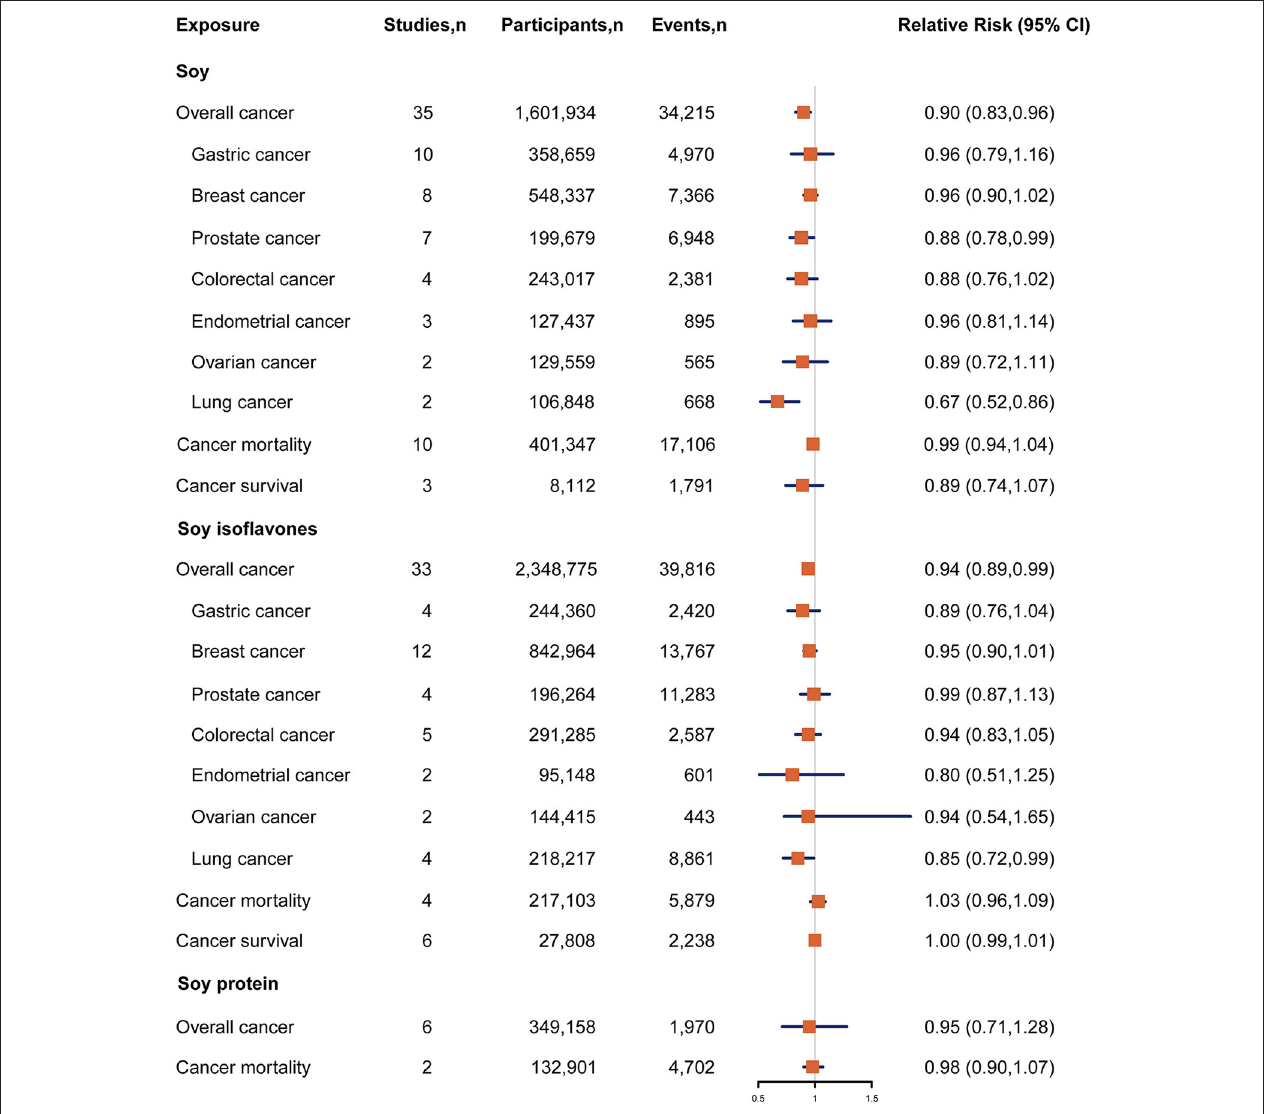
FIGURE 2 | Forest plot for association between soy, soy isoflavones and soy protein intake and risk of cancer incidence and cancer mortality, expressed as comparison between highest and lowest categories of soy, soy isoflavones and soy protein intake. The size of the black squares reflects the relative statistical weight of study-specific estimate, horizontal lines indicate 95% CIs. The diamond indicates the pooled RR estimates with 95% CIs. CI, confidence interval; RR, relative